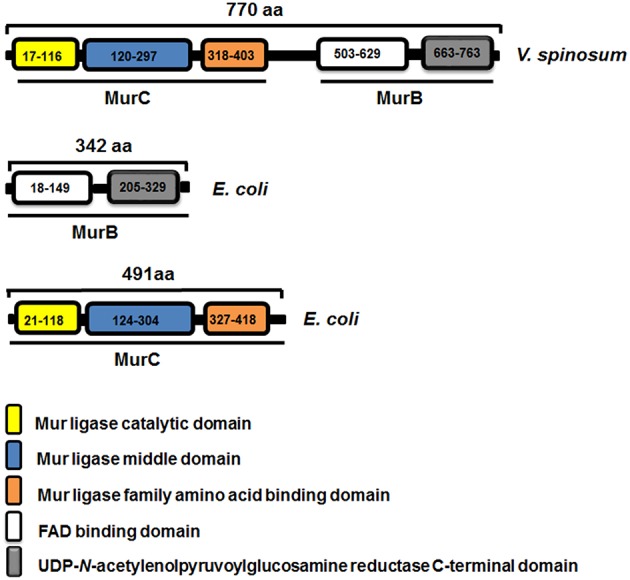
Domain mapping of the MurB/CVs fusion enzyme of V. spinosum and the individual MurB and MurC enzymes from E. coli showing the predicted Pfam domains and residue locations of the individual domains.